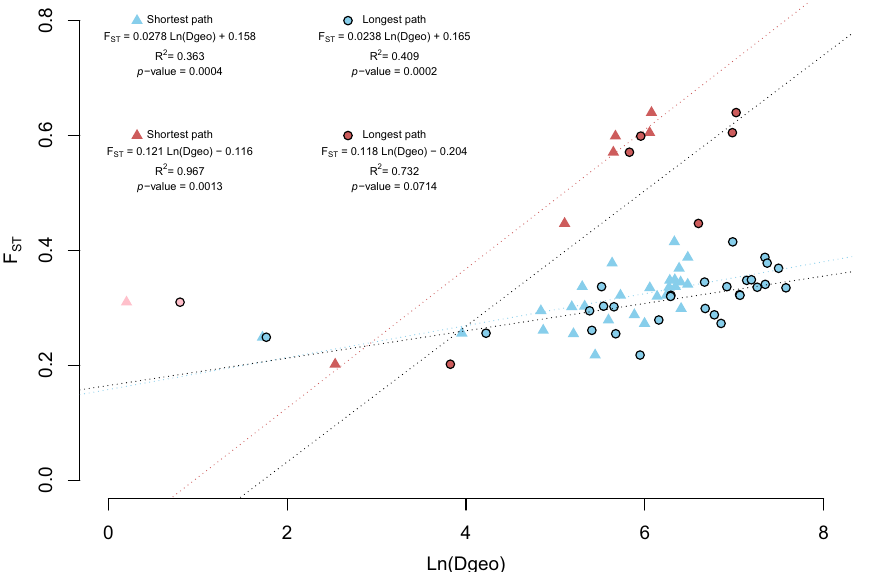
Figure 4. Genetic Isolation by distance in Gongolaria barbata in the Adriatic and Black Seas based on the shortest (diamond) and the longest path (circle). Distances displayed are site pairwise F ST (y-axis) and natural logarithm of oceanographic distances (x-axis). IBD was performed without the sampling site 11 in the Black Sea. This figure was created using the R software 107